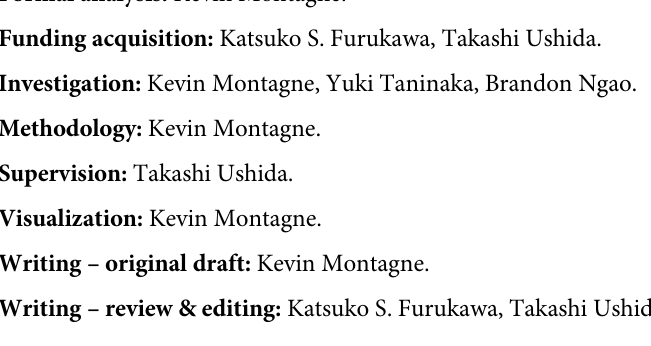
S1 Fig. Mir155hg RACE and sequencing of 5’ and 3’ ends. The sequence marked in yellow is the sequence of the 5’ RACE-PCR product; the sequence marked in grey is the sequence of the 3’ RACE-PCR product. The exons 1 and 2 reported in the NCBI database (NCBI Reference Sequence NR_132106.1) are underlined. The pre-miR-155 sequence is in bold. The forward (Fx) and reverse (Rx) PCR primers used for S2 Fig are respectively colored in red and blue. S2 Fig. Gel electrophoresis of PCR products generated along the Mir155hg cDNA sequence. PCRs were carried out using the Taq DNA Polymerase with Standard Taq Buffer (New England Biolabs) on ATDC5 cDNA using the primers shown in S1 Fig. The primers were designed to produce overlapping products covering the whole Mir155hg sequence (between primers F1 and R5). Two ladders were used; the lengths of some of the bands, in base pairs (bp), are shown on the side of each image. Under each lane, the primers used and the size of each amplicon expected if the PCR were carried out on genomic DNA is